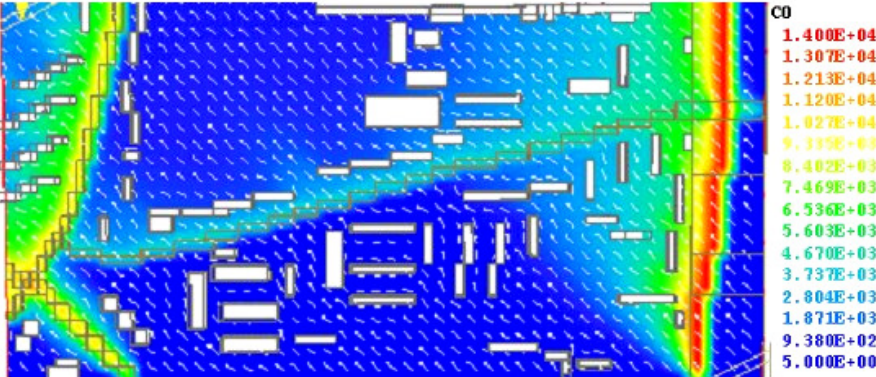
3 ir greičio vektoriai 1,5 m nuo žemės pa- 3 and vector of speed 1,5 m from su- 3 3 , DLK – 5,0 µ g/m